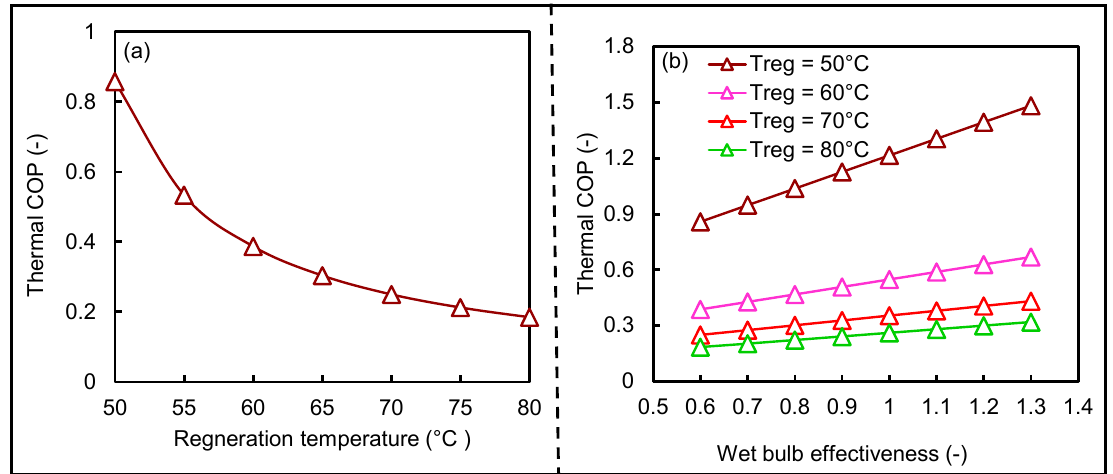
Figure 6. Comparison of thermal coefficient of performance (COP) at ( a ) wet-bulb effectiveness = 0.6; and ( b ) different wet-bulb effectiveness against different regeneration temperatures.